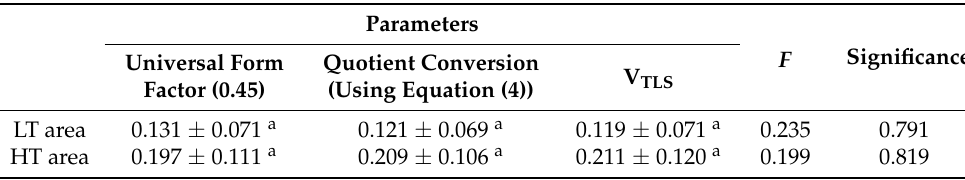
Table 2. Average tree volumes obtained with different